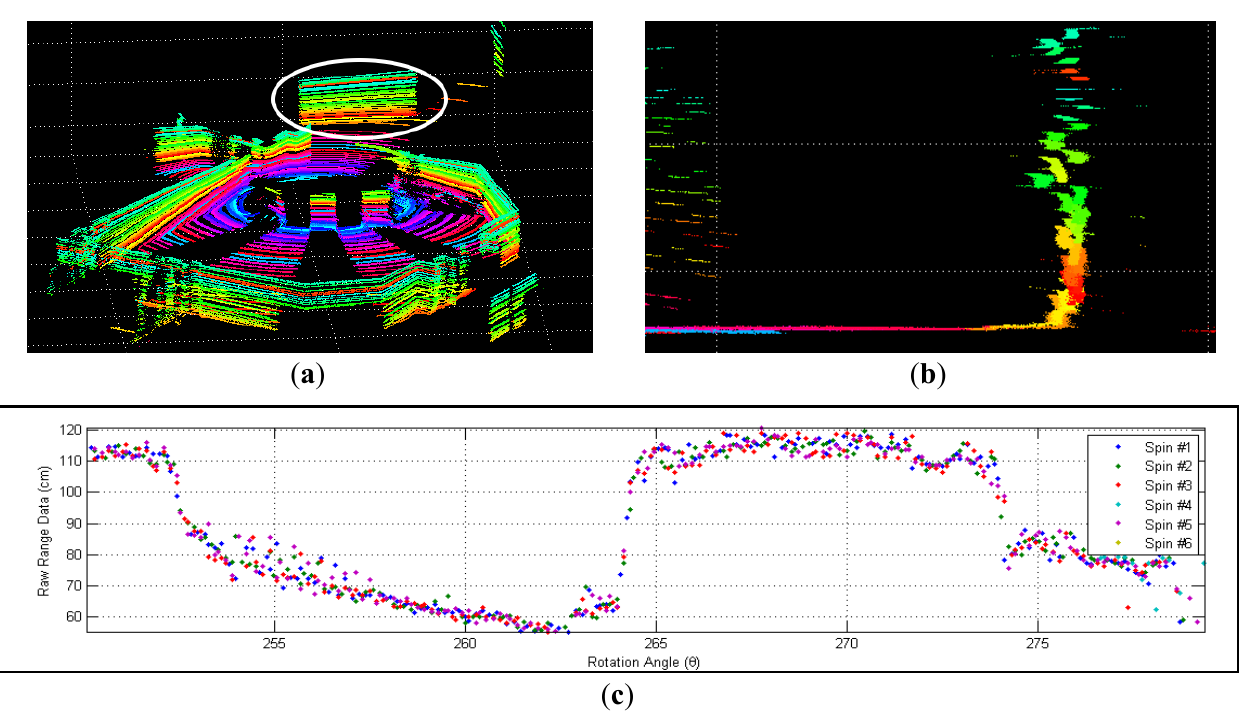
Figure 1. ( a ) point cloud of corridor; colour-coded to differentiate laser sources; ( b ) A close look at the marked wall; ( c ) range data of laser #40 returned in six subsequent